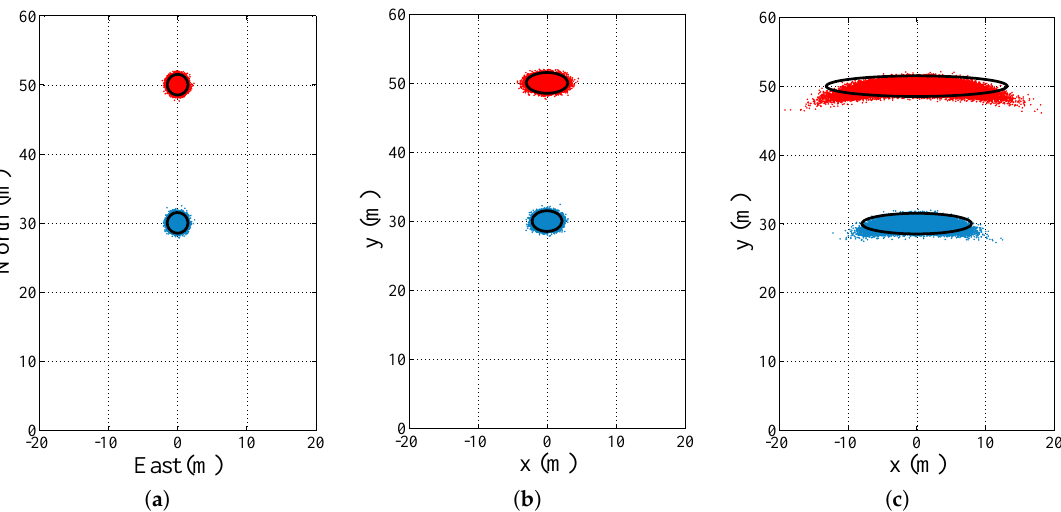
Figure 4. The figures show the uncertainty in the relative position of a vehicle driving 30m (blue) and 50m (red) ahead. The red and blue dots are the particle clouds, and the black ellipses are the linearized Gaussian uncertainty. Figure ( a ) shows the relative position in the navigation frame coordinates with a 0.5m (1 σ ) error in the north and east direction. After rotating this position into the ego vehicle frame using the ego vehicle’s heading angle with an uncertainty of 1 ◦ (1 σ ) in Figure ( b ) and 5 ◦ (1 σ ) in Figure ( c ), the uncertainty in the relative position is clearly